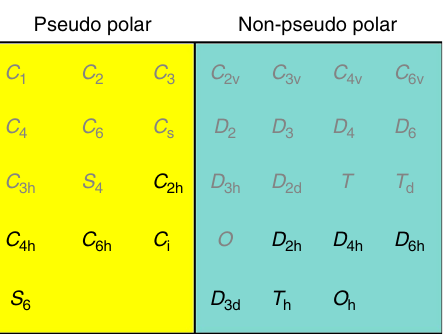
Fig. 2 Classi fi cation of 32 crystal point groups into pseudo-polar and non- pseudo-polar point groups. The point group symbols labeled by gray (black) color are non-centrosymmetric (centrosymmetric) Table 1 Symmorphic space groups which might host BSVSP Crystal point groups